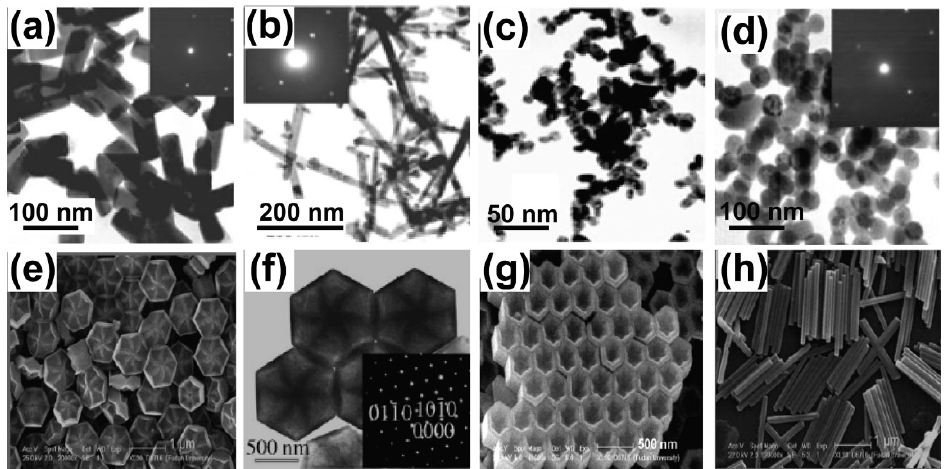
Figure 4. TEM and SEM images of NaYF 4 :Yb/Er nanocrystals prepared under different hydro/solvothermal conditions. ( a , b ) TEM images of NaYF 4 :Yb/Er nanocrystals synthesized in acetic acid and ethanol in the presence of CTAB, respectively; ( c , d ) TEM images of NaYF 4 :Yb/Er nanocrystals using EDTA in acetic acid and ethanol, respectively. Reproduced from [34]. Copyright 2005, John Wiley and Sons; SEM images of ( e , f ) flower-patterned hexagonal disks; ( g ) hexagonal nanotubes; and ( h ) nanorods of β -NaYF 4 . Reproduced from [51]. Copyright 2007, John Wiley and